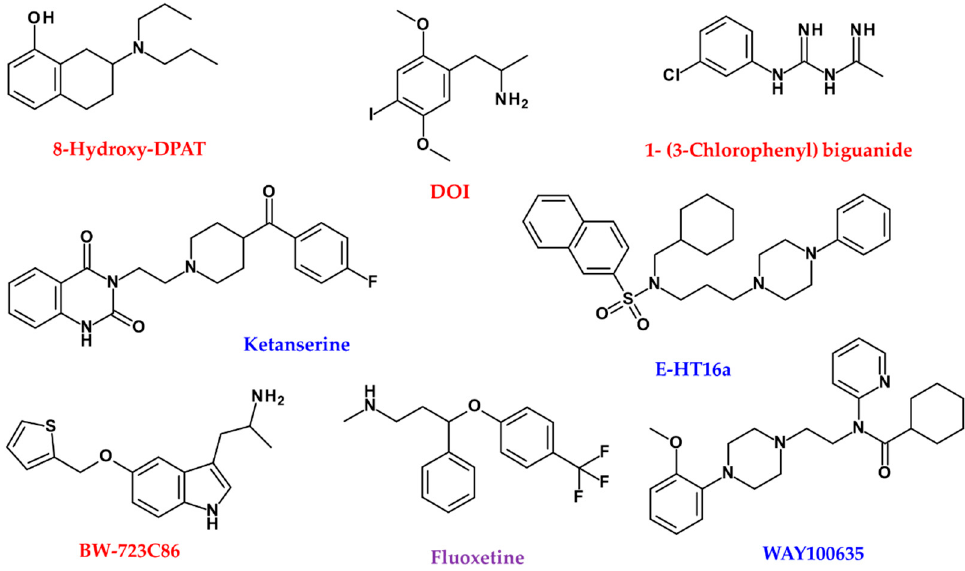
Figure 7. Chemical structures of agonist (red), antagonist (blue), and enzyme inhibitors or others (purple) related to serotonin neurotransmitters. (purple) related to serotonin